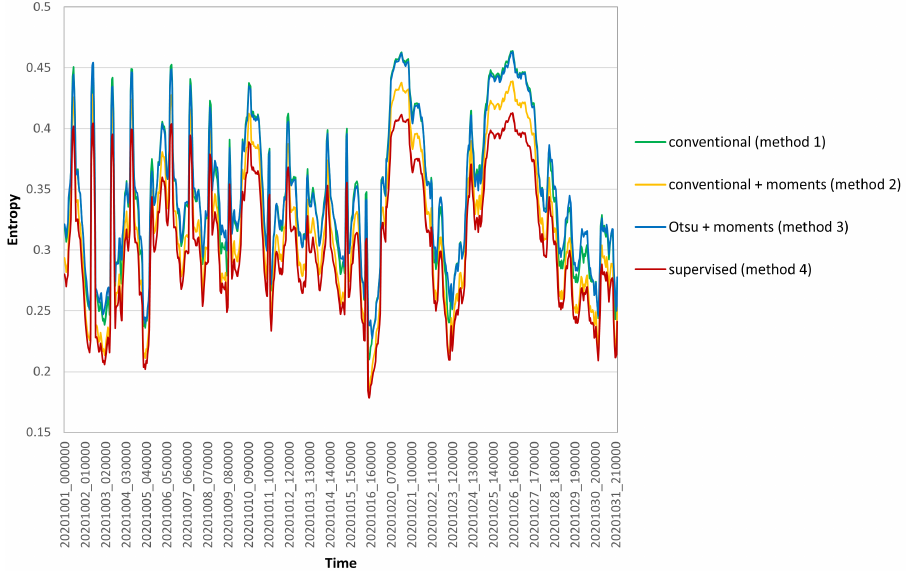
Figure 8. Results of entropy calculation for set C; see Table